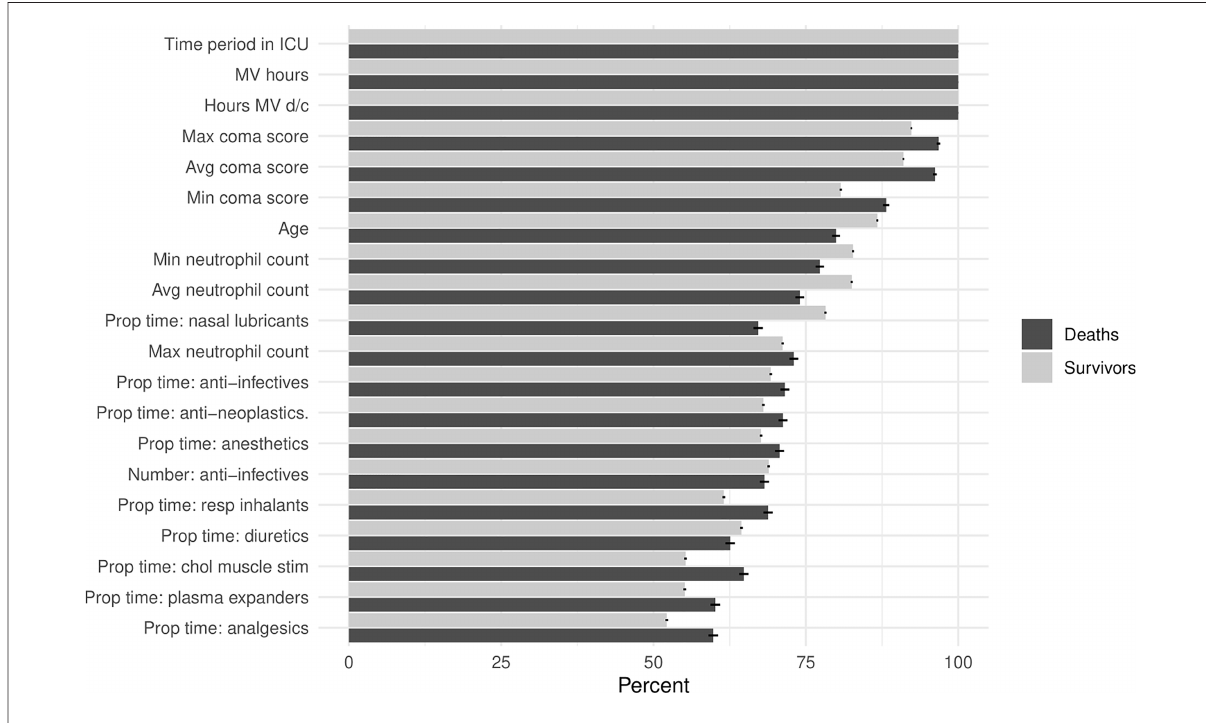
FIGURE 4 Variable importance for the Criticality Index-Mortality (CI-M) model . Percentages of the most frequently important covariates determined by the LIME methodology. MV=mechanical ventilation, d/c=discontinued, max=maximum, avg=average, min=minimum, prop=proportion, resp=respiratory, chol= cholinergic,